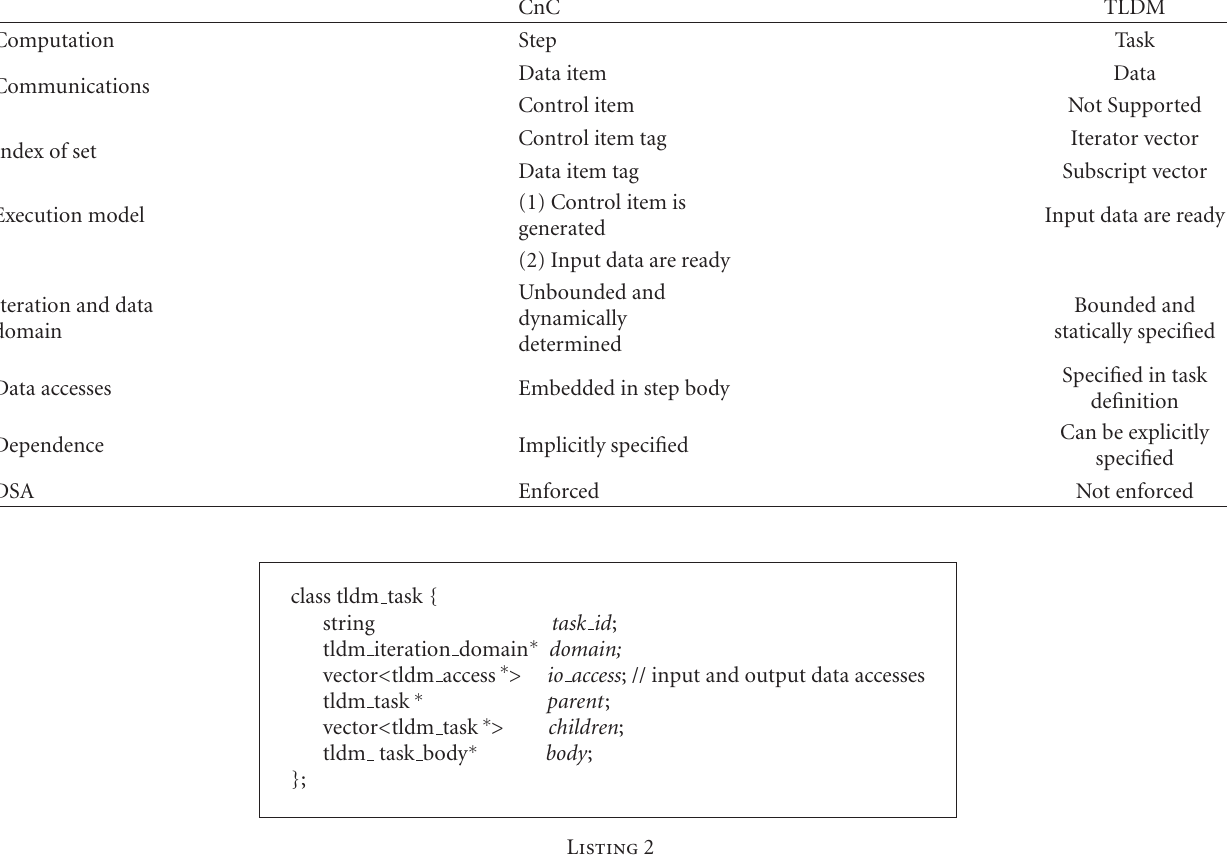
Table 1: Syntax and semantics summary of CnC and